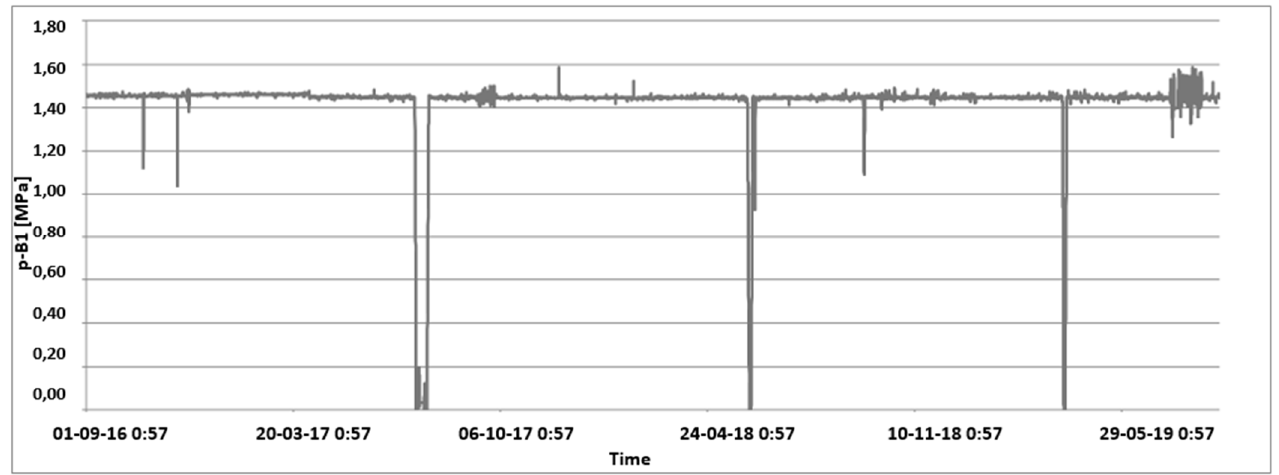
Figure 17. Annual internal pressure in the vessel change.